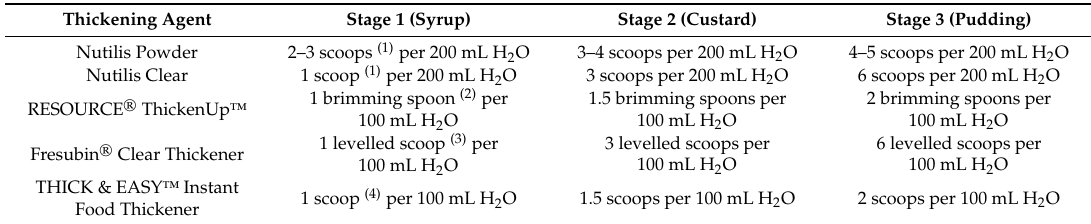
Table 1. Instruction for use of thickening agent.